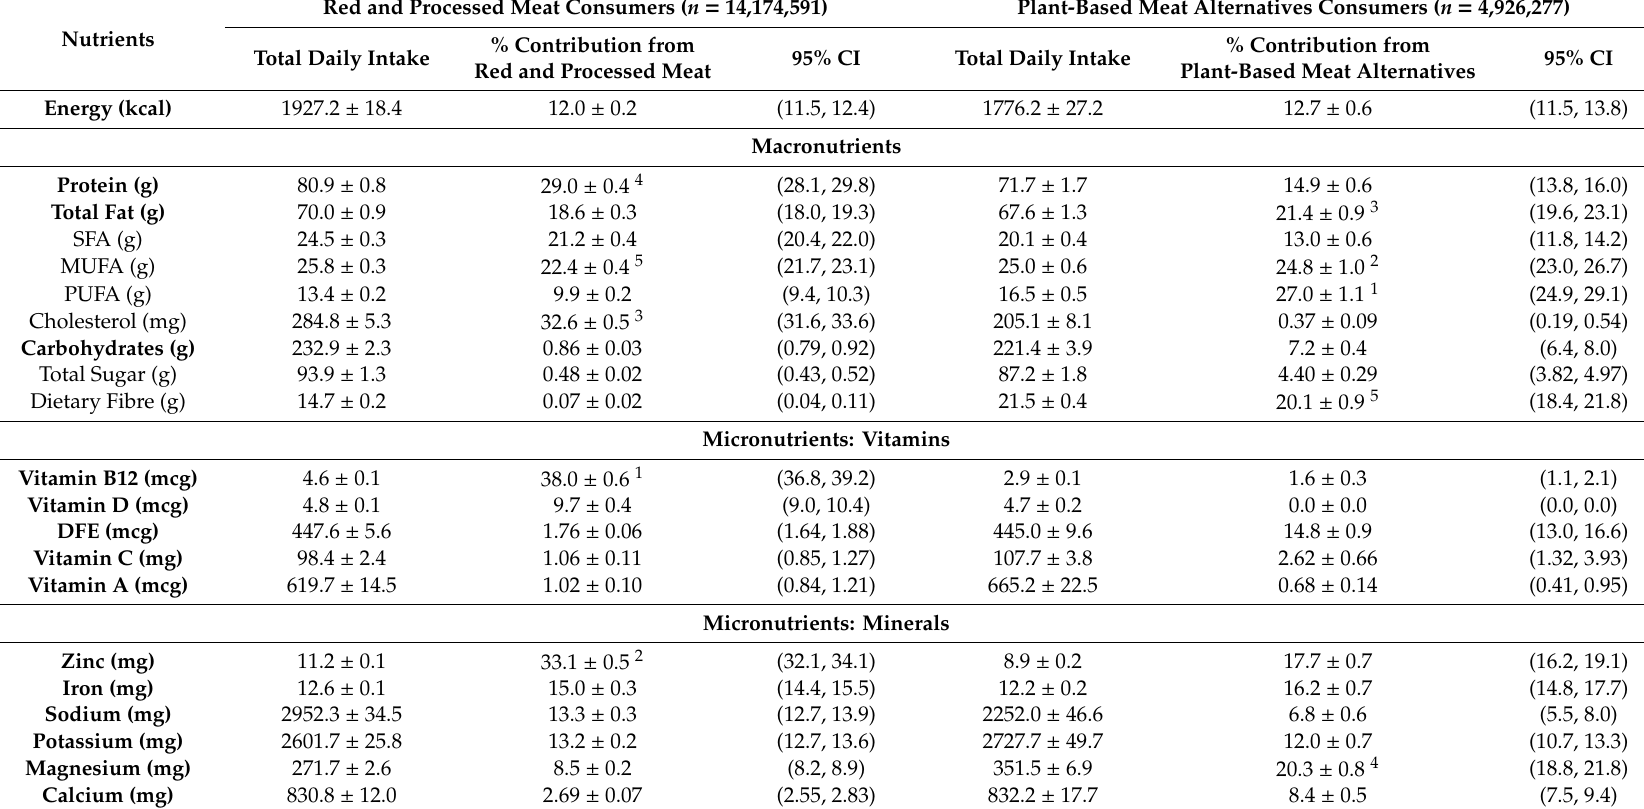
Table 3. Percent energy and nutrient contribution of red and processed meat and plant-based meat alternatives to the daily nutrient intake of the red and processed meat consumers and the plant-based alternatives